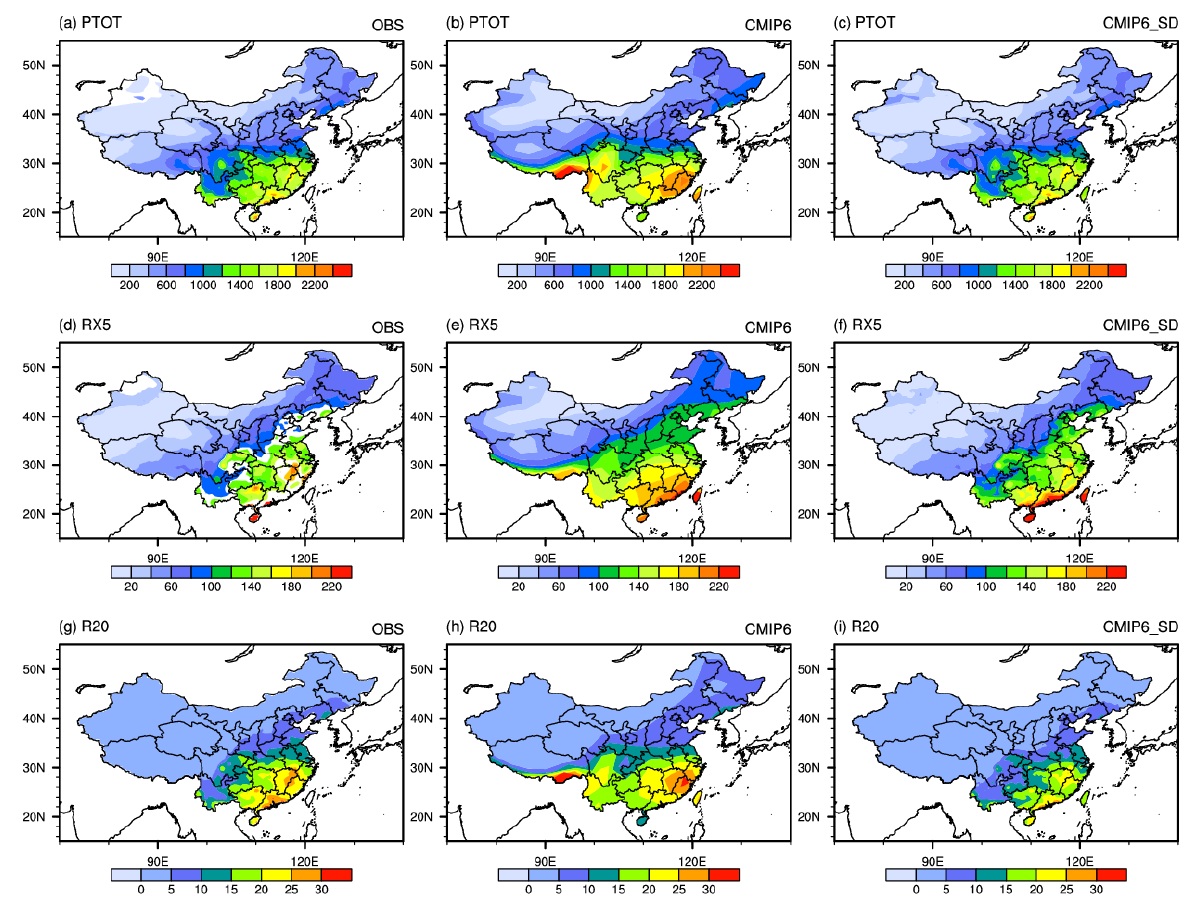
Figure 1. Spatial patterns of extreme precipitation indices (PTOT and RX5, units: mm; R20, units: days) in China (1961–2014) for observation ( left panel), CMIP6 multi-model-ensemble (MME) ( middle panel), and MME of downscaled dataset ( right panel). Table 3. Performance of extreme climate indices for CMIP6 climate models and SD